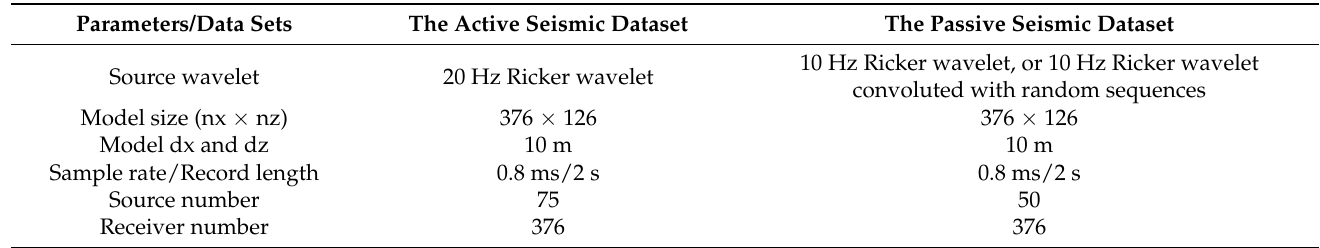
Figure 1. The complex velocity model of a metal ore body from the Luzong Basin, China. The active sources, passives sources, and receiver locations are marked with different marks, as shown in the right upper corner of the figure. Table 1. Modeling parameters for the active and passive seismic datasets.